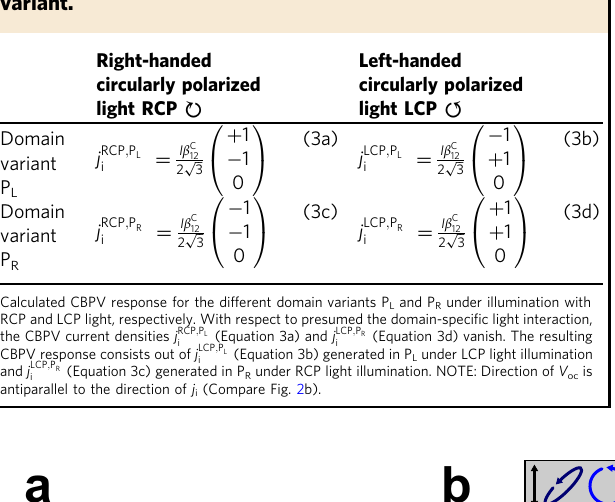
Table 1 CBPV contribution from each ferroelectric domain